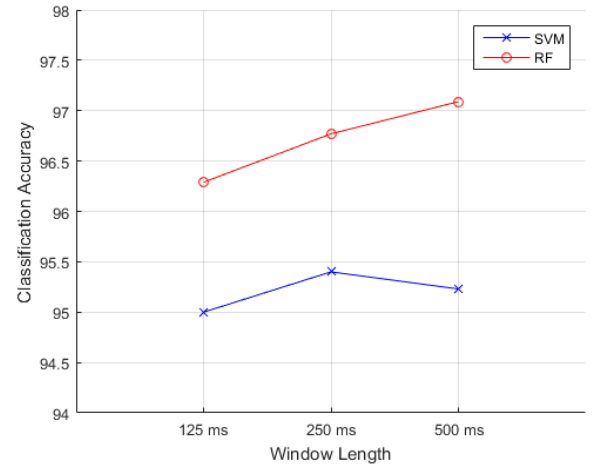
Figure 10. Effect of window length on the classification accuracy. The classification accuracies are averaged over all nine subjects.